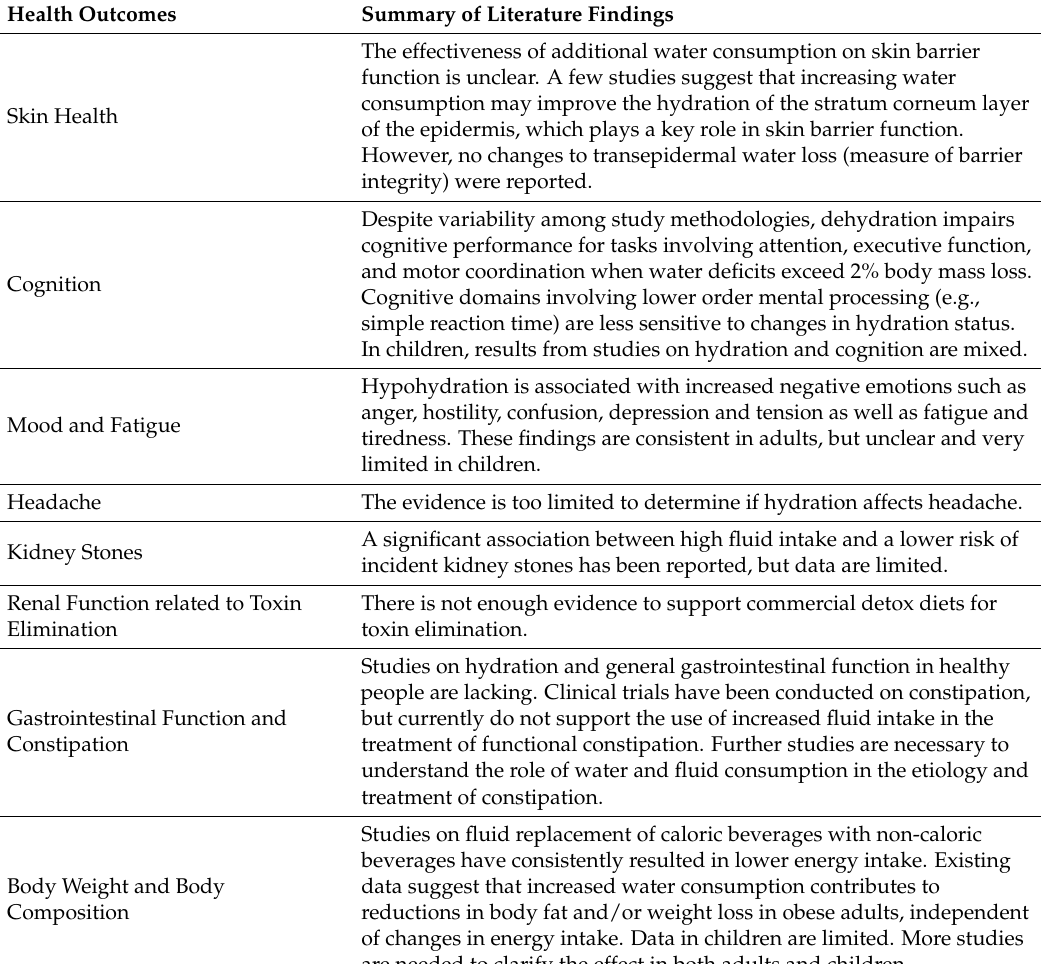
Table 5. Summary of Literature